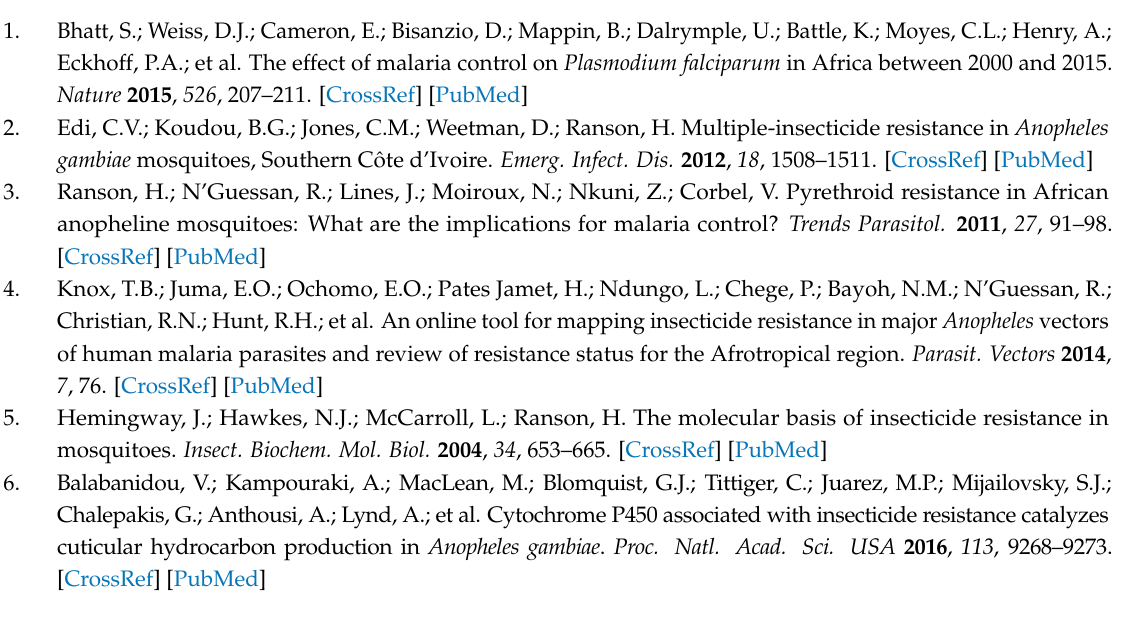
Table S1: Mosquito specimens suitable for use as artificial populations; Table S2: Primers and probes used in the present study; Table S3: Quality control characteristics of the qPCR reactions; Table S4: Alternative methods of calculation using normalization with exon EF or the Ct value of the mutant probe; Table S5: Results from populations where only 1014F an 1014S individuals were present in different proportions (no wild type mosquitoes present); Figure S1: Residual plot analysis for the selection of optimal regression model between linear and polynomial regression models; Figure S2: A practical approach on how to setup the experimental procedure to calculate allelic frequencies from standard mosquito pools and how to apply it in each run for unknown pooled